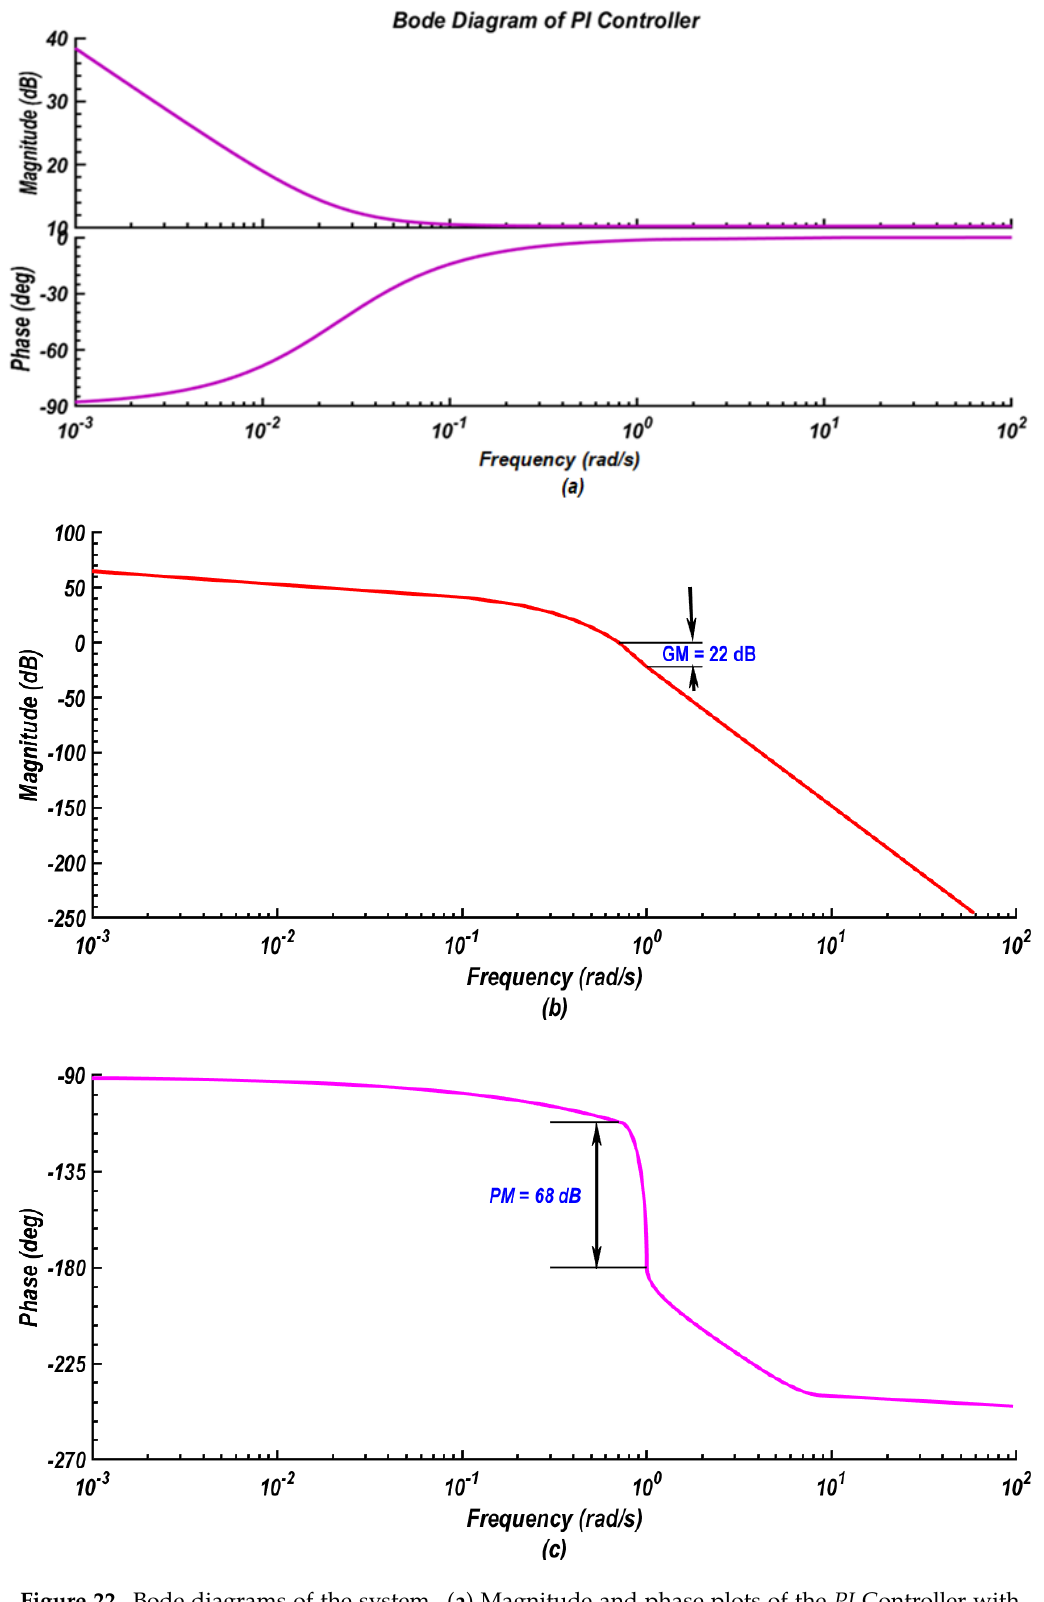
Figure 22. Bode diagrams of the system. ( a ) Magnitude and phase plots of the PI Controller with KP = 3.27 and KI = 0.083. ( b ) Magnitude plot of the open-loop transfer function of the controller-plant system, GpGc , and ( c ) Phase plot of the open-loop transfer function of the controller-plant system, GpGc.